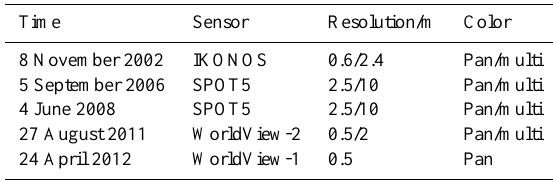
Table 1. Inventory of images used in the